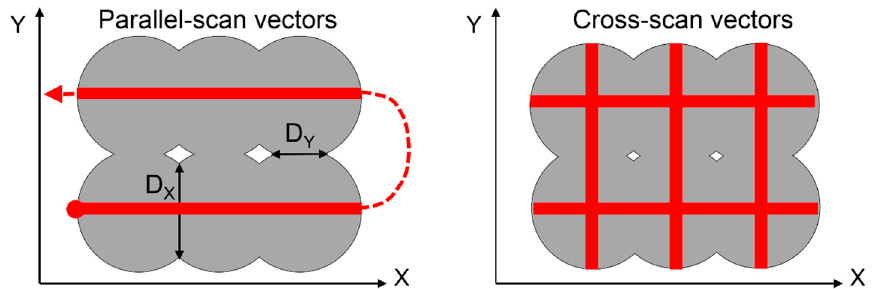
Figure 2. Dimension of necking diameters in relation to the applied scan vectors (modificated 28).